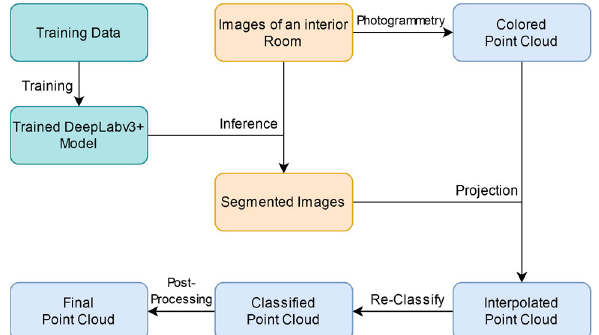
Figure 1. Overview of our workflow. Images of an interior room are the input for inference with our trained neural network and the photogrammetric point cloud generation. An interpolated point cloud is produced by projection of the segmented images. This point cloud is reclassified and used as the input in the final post-processing step.